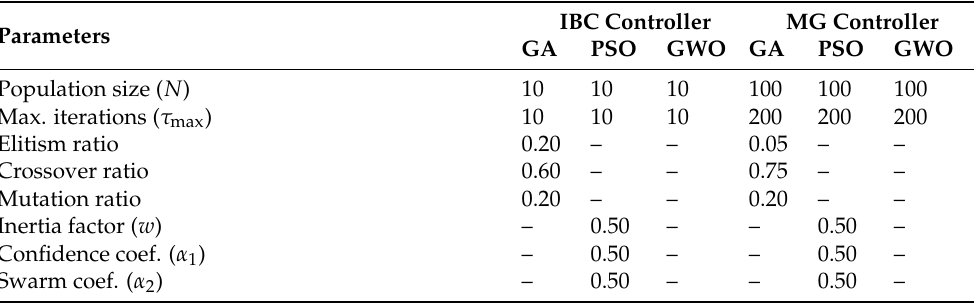
Table 3. Simulation parameters used for the metaheuristics when designing different kinds of